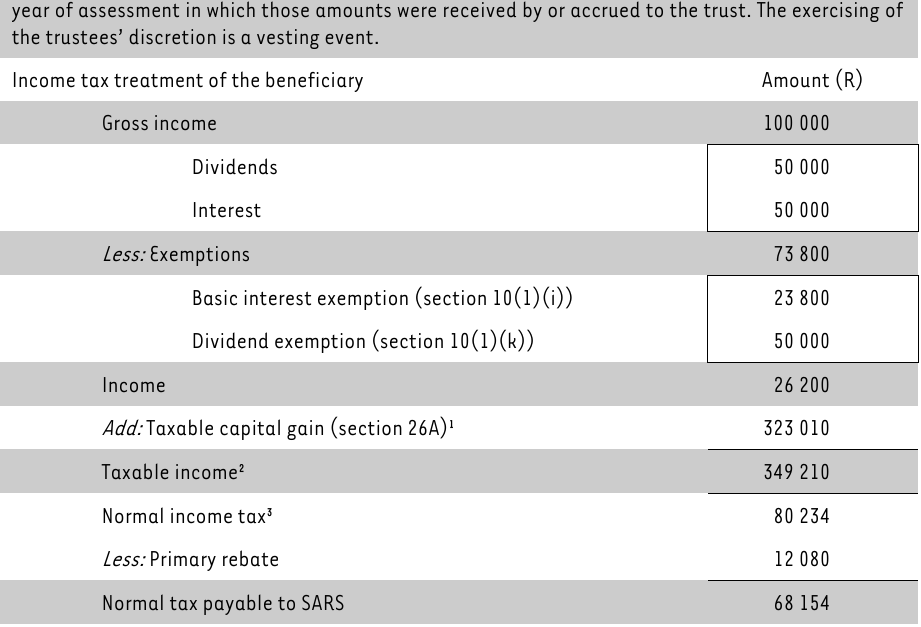
Current income tax treatment – all receipts and accruals vest in beneficiary Income tax treatment of the discretionary trust Amount (R) Taxable income